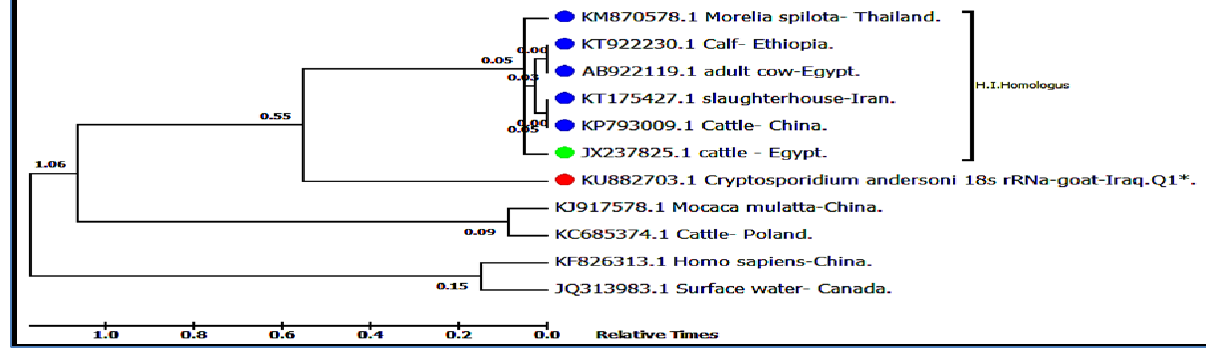
Figure, 5: Phylogenetic tree depend on the Neighbor joining tree method. The phylogenetic distances analyses were conducted by MEGA6.*Red spot: C. andersoni strain isolated from Iraq.*Green spot: Strain high homologous with Iraqi – C. andersoni isolated from goat. *Blue spot: Strains highly identity with Iraqi – C. andersoni isolated from